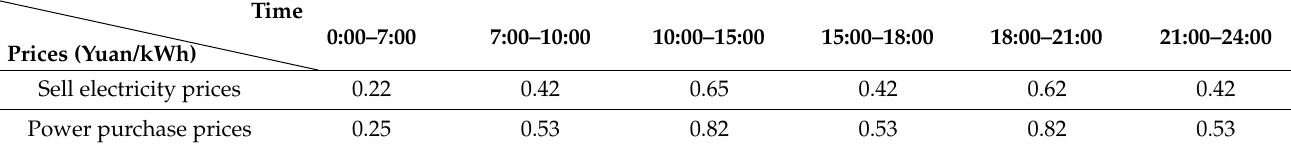
Table 4. Time-of-use electricity